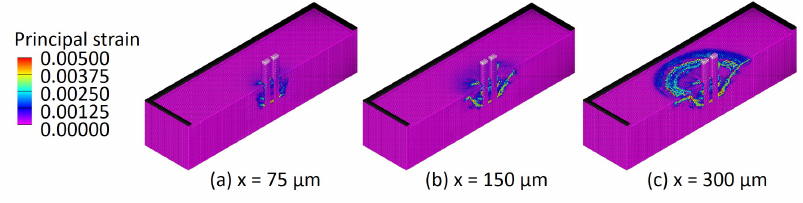
Figure 22. Crack development when the spacing s is 25